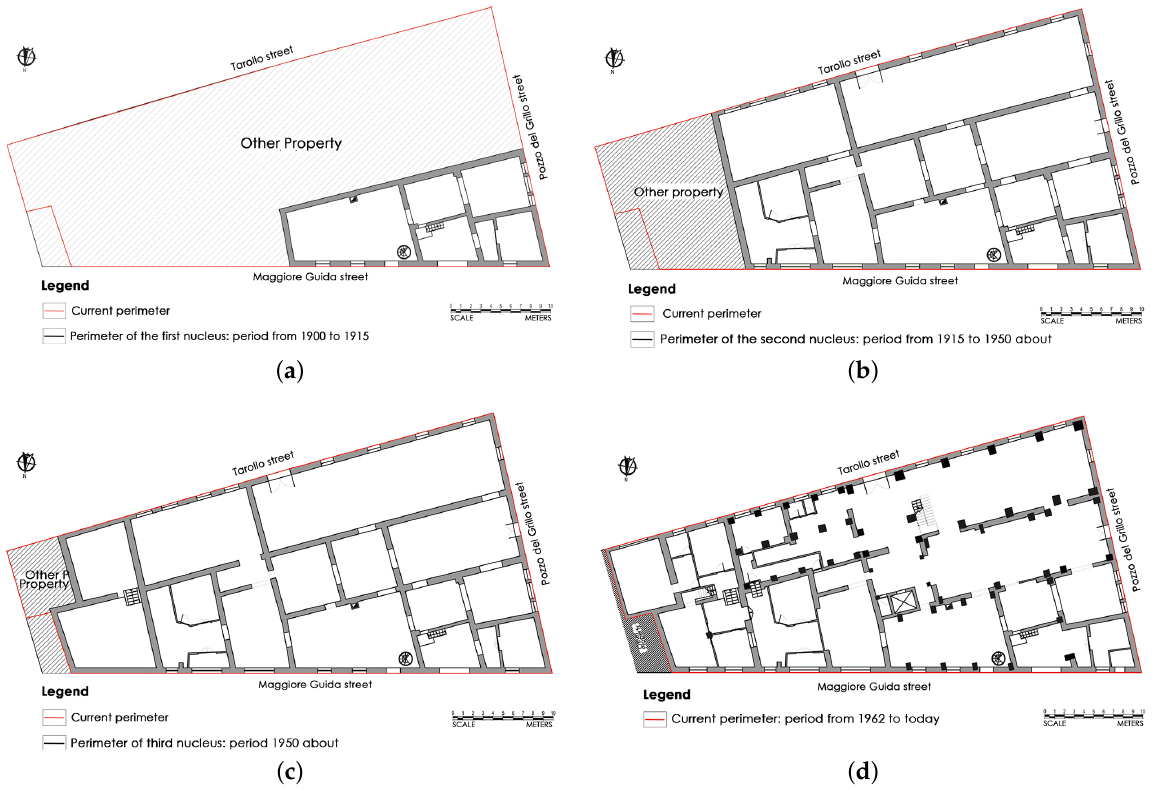
Figure 5. Constructive evolution: from 1900 about to 1960 about. ( a ) 1900 about; ( b ) 1915 about; ( c ) 1950 about; ( d ) 1960